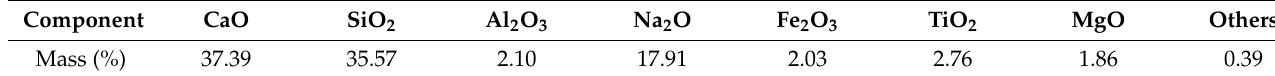
Table 1. Chemical composition of AER ( ω t%).